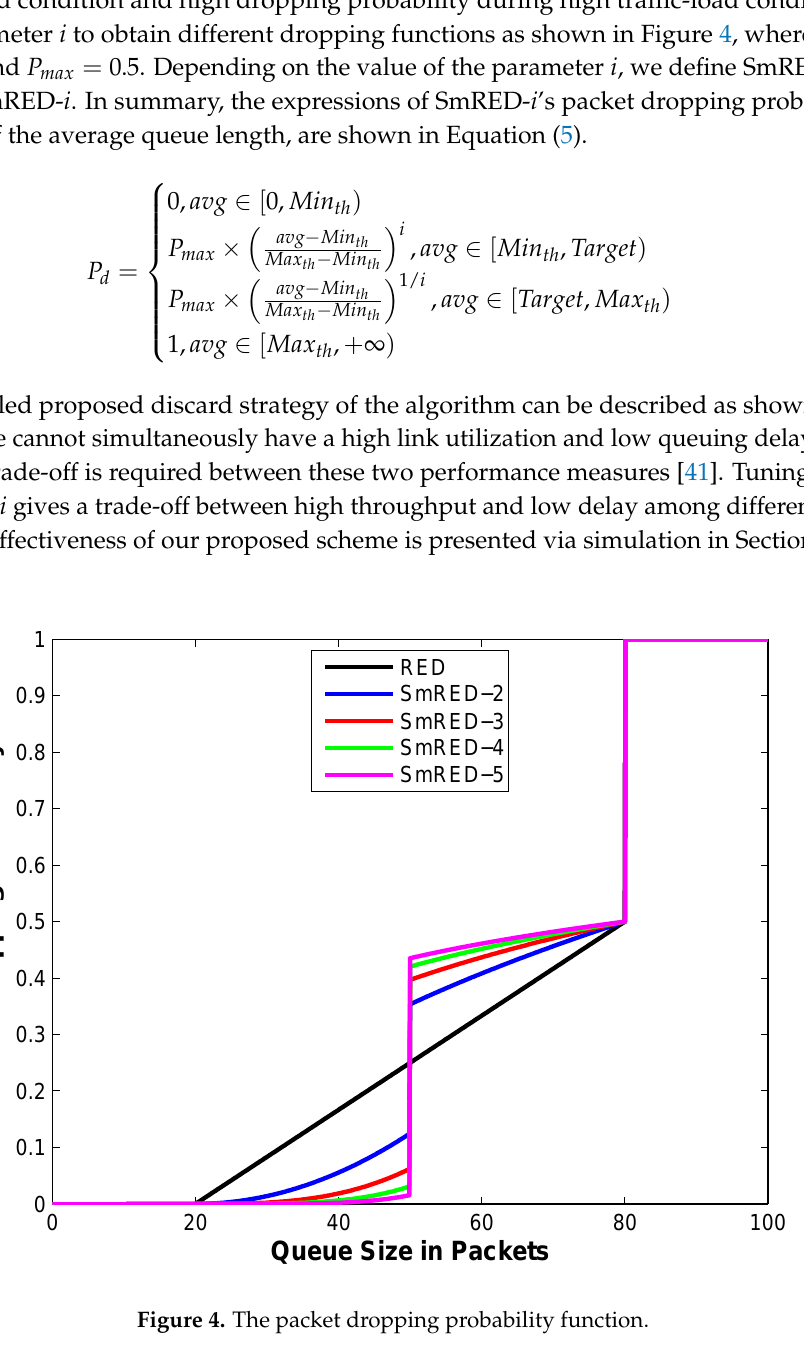
Figure 4. The packet dropping probability